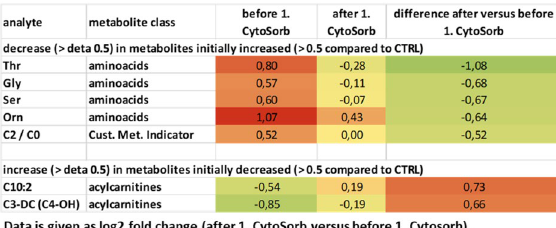
Table 4. Difference in metabolites after first CytoSorb versus before first CytoSorb measured by mass spectrometry. Tables shows metabolites that were initially increased > 0.5 and decreased more than > 0.5 as well as metabolites that were initially decreased and increased more than > 0.5. All values are given as Log2 (FSGS patient/stable transplanted